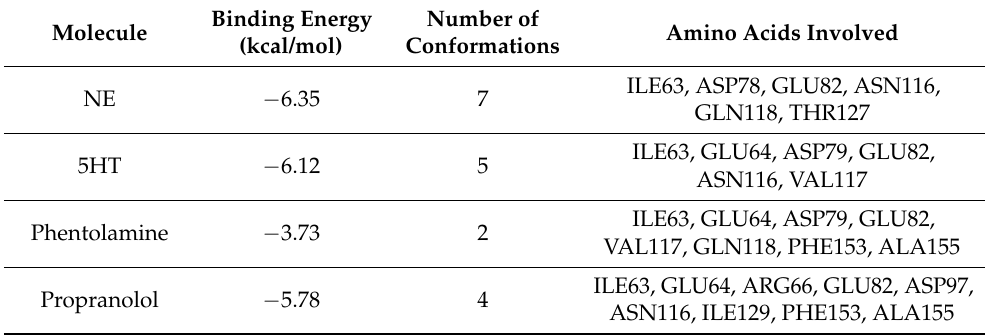
Table 2. The binding energy, number of conformations in the selected cluster, and the amino acids involved in the interaction site of VicK (WalK) for the four ligands